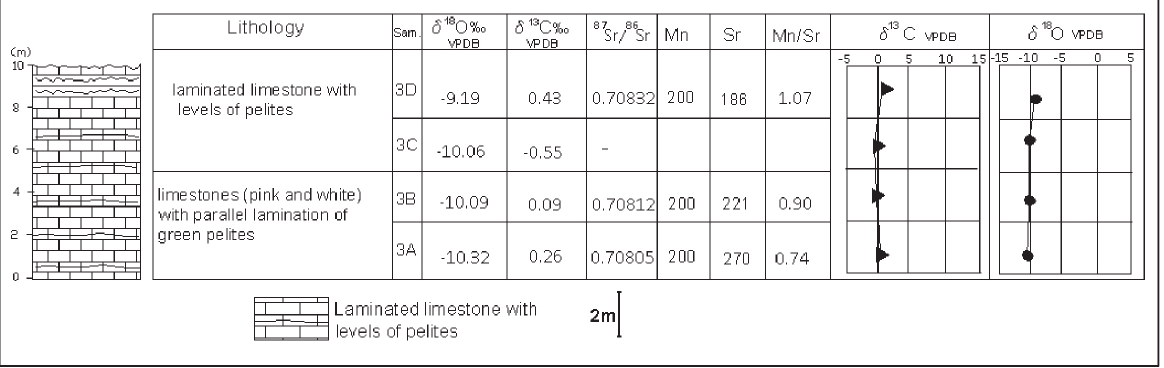
Figure 10 - Lithological variations, elemental and isotopic data of Section 4– laminated limestones at the quarry of the Rodeador district, Bambuí Group (for location, see Fig. 3).